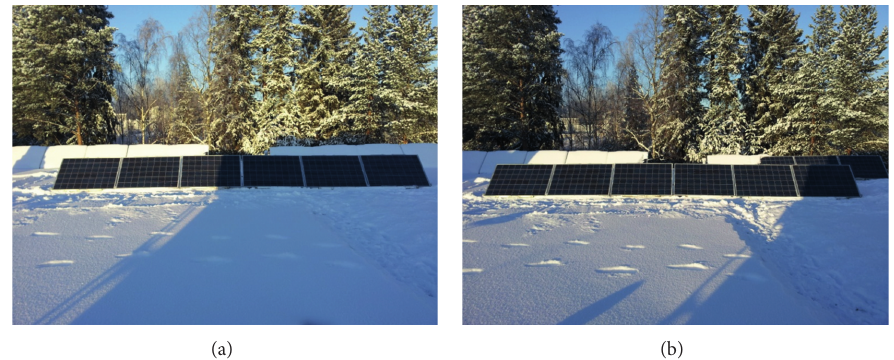
Figure 13: Figures of the operational conditions of String 4 under partial shading conditions caused by a building structure during the electrical measurements on December 4th, 2012: (a) conditions of measurement 1 with 2 nonshaded PV modules and 4 fully or partially shaded PV modules, (b) conditions of measurement 4 with 5 nonshaded PV modules and 1 partially-shaded PV module.